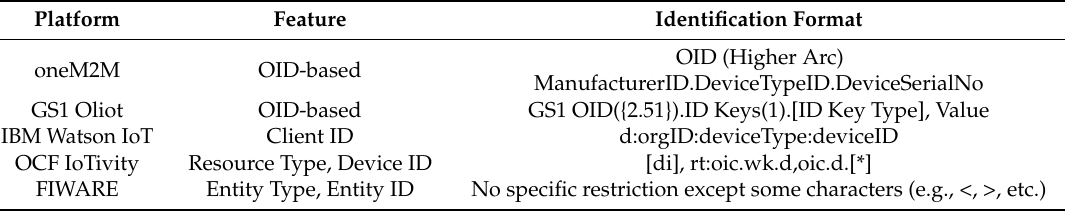
Table 1. Comparison of four Internet of Things (IoT) platforms’ identification systems.